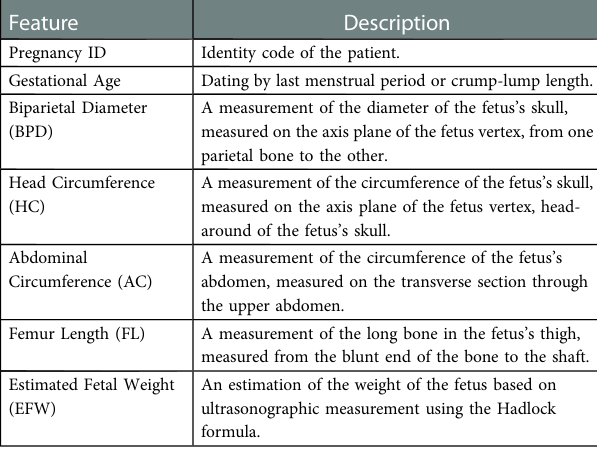
TABLE 1 Description of features collected in prenatal